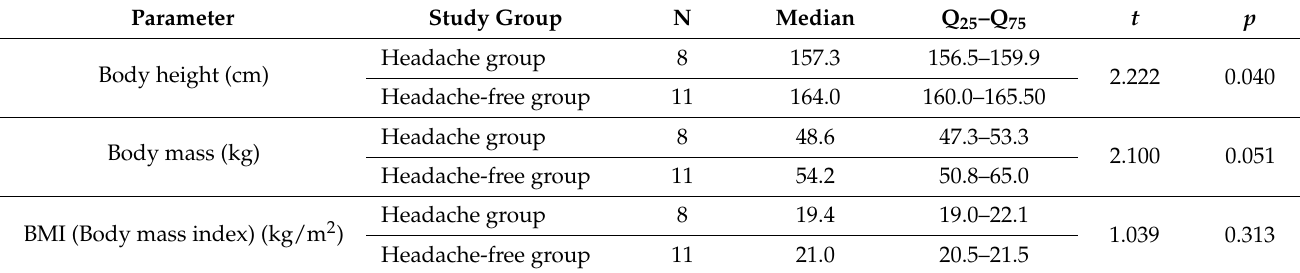
Table 1. Characteristics and differences between anthropometric parameters.